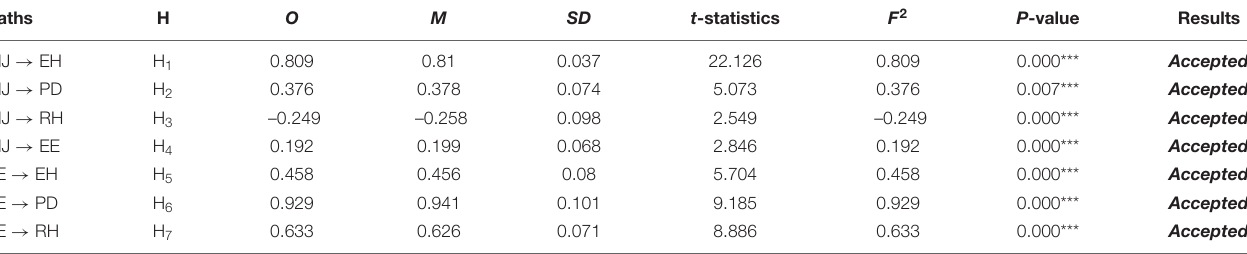
TABLE 7 | Direct effects of the variable. Paths